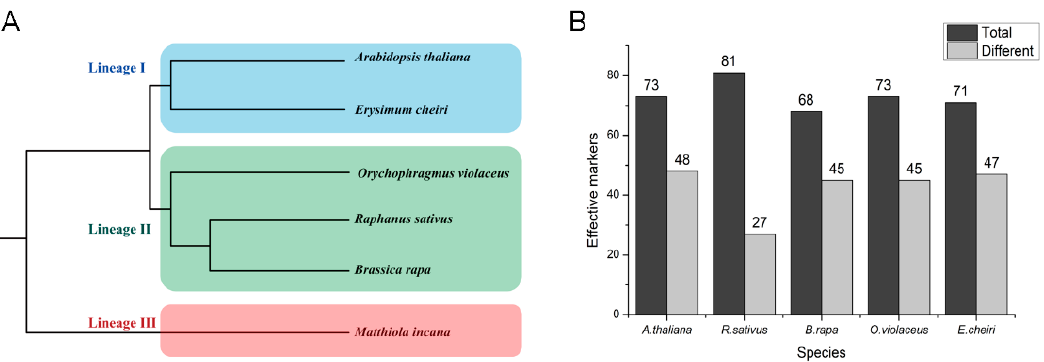
Figure 6. The transferability and effectiveness of SSR primers in five Brassicaceae species. ( A ) The phylogeny of species in Brassicaceae used in this study referenced from Chen et al. (2018). ( B ) The distribution of effective primer pairs in different species. “Total” represents the total number of effective primer pairs in the species; “Different” represents the number of effective primer pairs that have different bands from M. incana in the species.